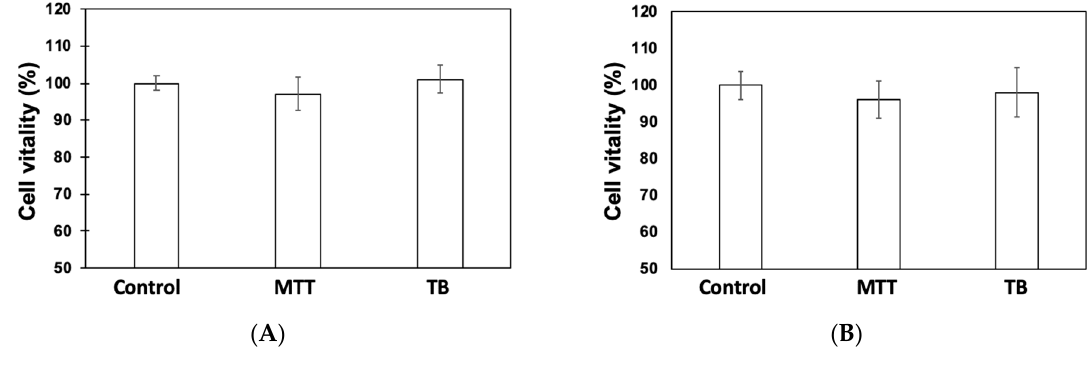
Figure 1. Assessment of Caco-2 cell vitality following treatment with native γ C ( A ) and with γ C-derived peptides ( B ) using the 3-[4–dimethylthiazol-2-yl]-2,5-diphenyltetrazolium bromide (MTT) method and direct cell counting (Tryphan Blue (TB)). Data are expressed as a percentage of the control sample.